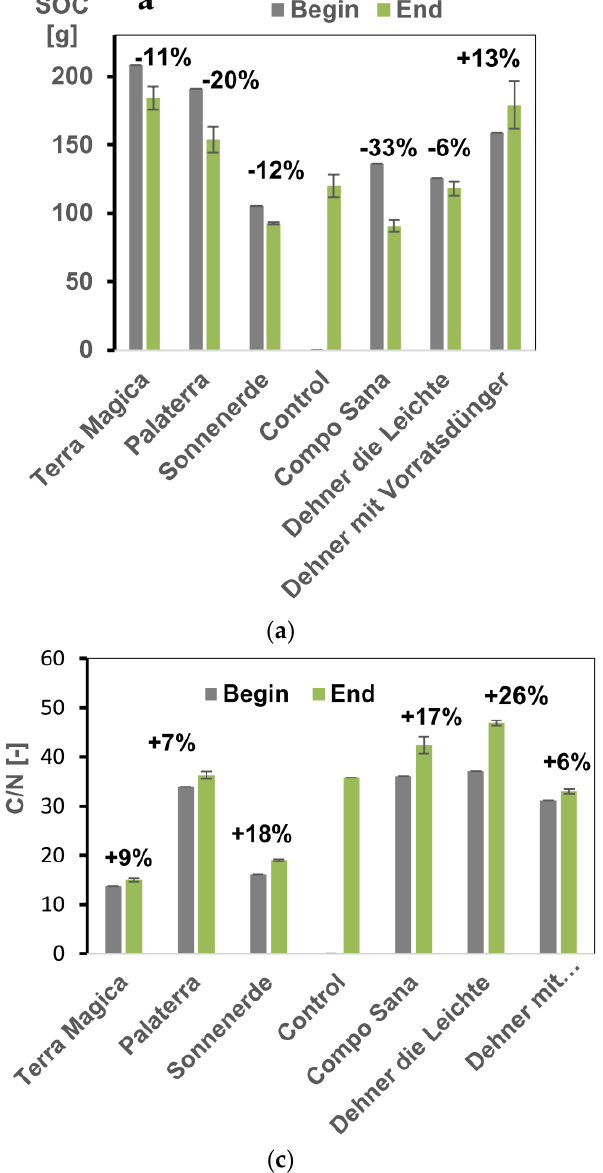
Figure 6. Total organic carbon and nitrogen balance of biochar- and peat-based growing media ( a ) Soil organic carbon ( b ) Total nitrogen stock and ( c ) C/N ratio.